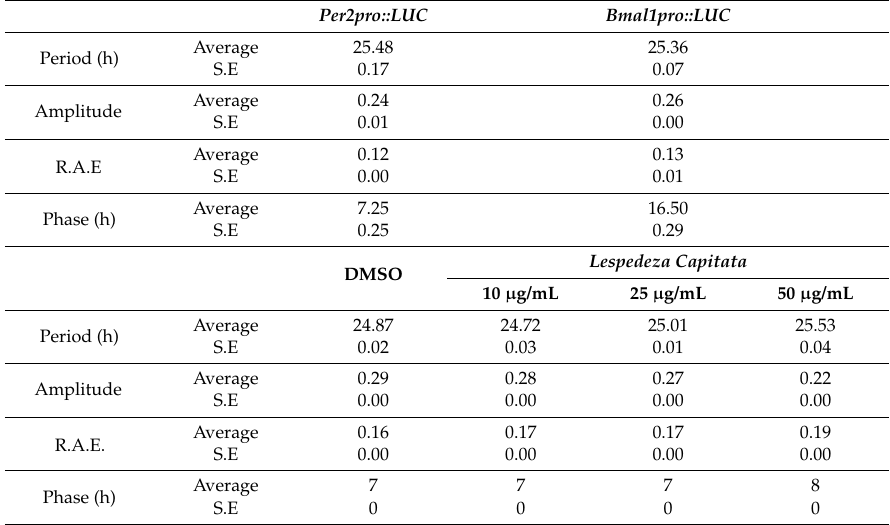
Table 1. Analysis of circadian rhythm. Relative luminescence intensities from each data in Figure 3A, C imported into the Biological Rhythms Analysis Software System (BRASS), and periods and relative amplitude error (RAE) were analyzed using the FFT-NLLS